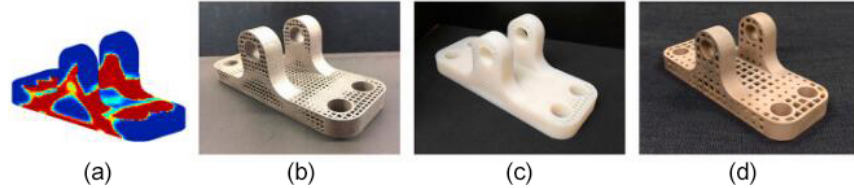
Figure 2. Stent optimized using different printing technologies; (a) topology optimization model; (b) direct laser sintering of small lattices; (c) fused deposition molding; (d) direct laser sintering of large lattices (Cheng et al., 2019).